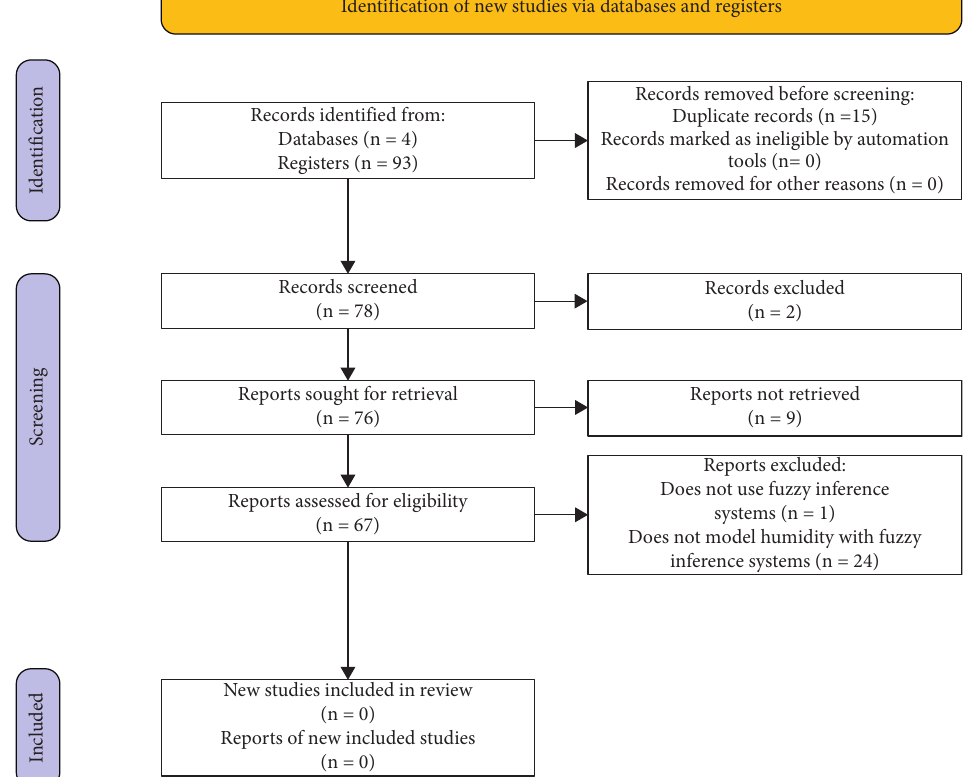
Figure 1: Flowchart for the identification of new studies for the review process. Adapted from [26].